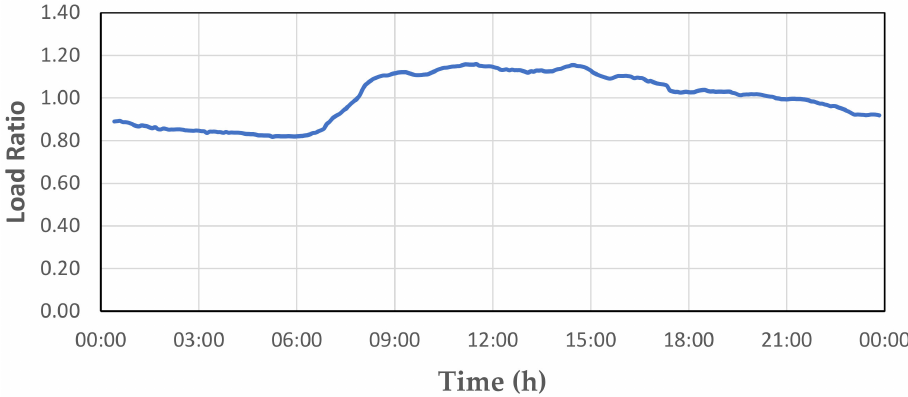
Figure 6. Average daily electrical energy consumption profile of Harran university hospital for 2019.